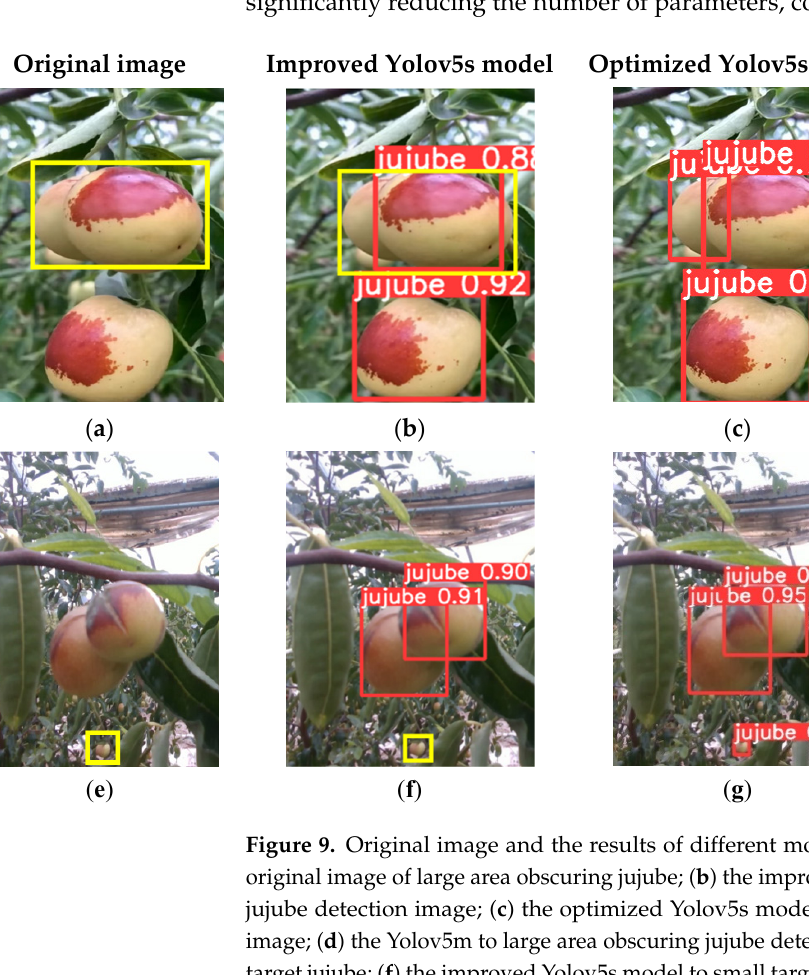
target jujube; ( f ) the improved Yolov5s model to small target jujube detection image; ( g ) the optimized